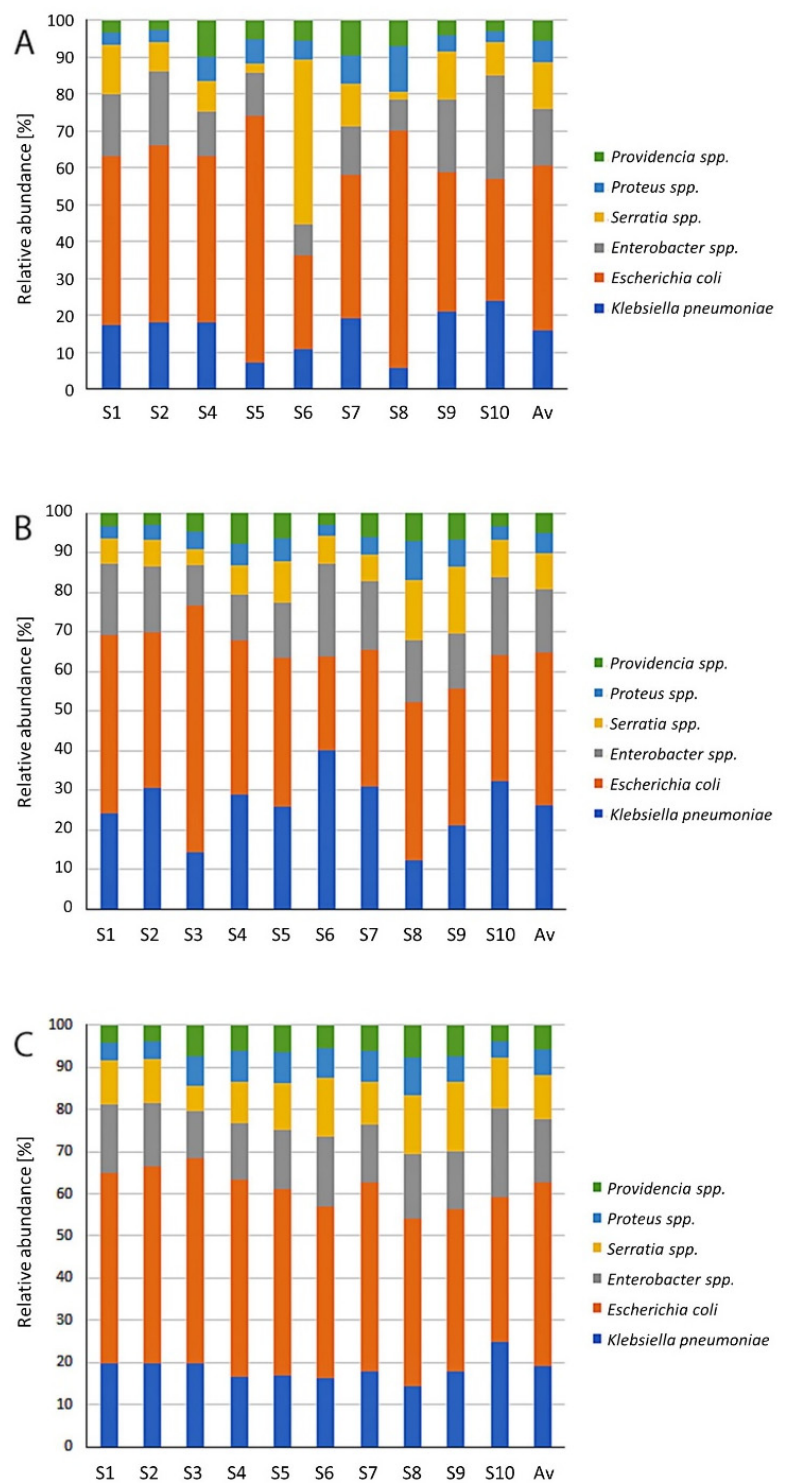
Figure 3. Technological and season changes of bacteria belonged to Enterobacteriaceae . ( A ) Summer (SUM); ( B ) autumn (AUT); ( C ) spring (SPR); Av—average.